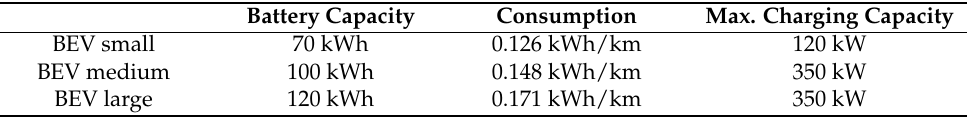
Table 2. Characteristics of different vehicle classes in 2040